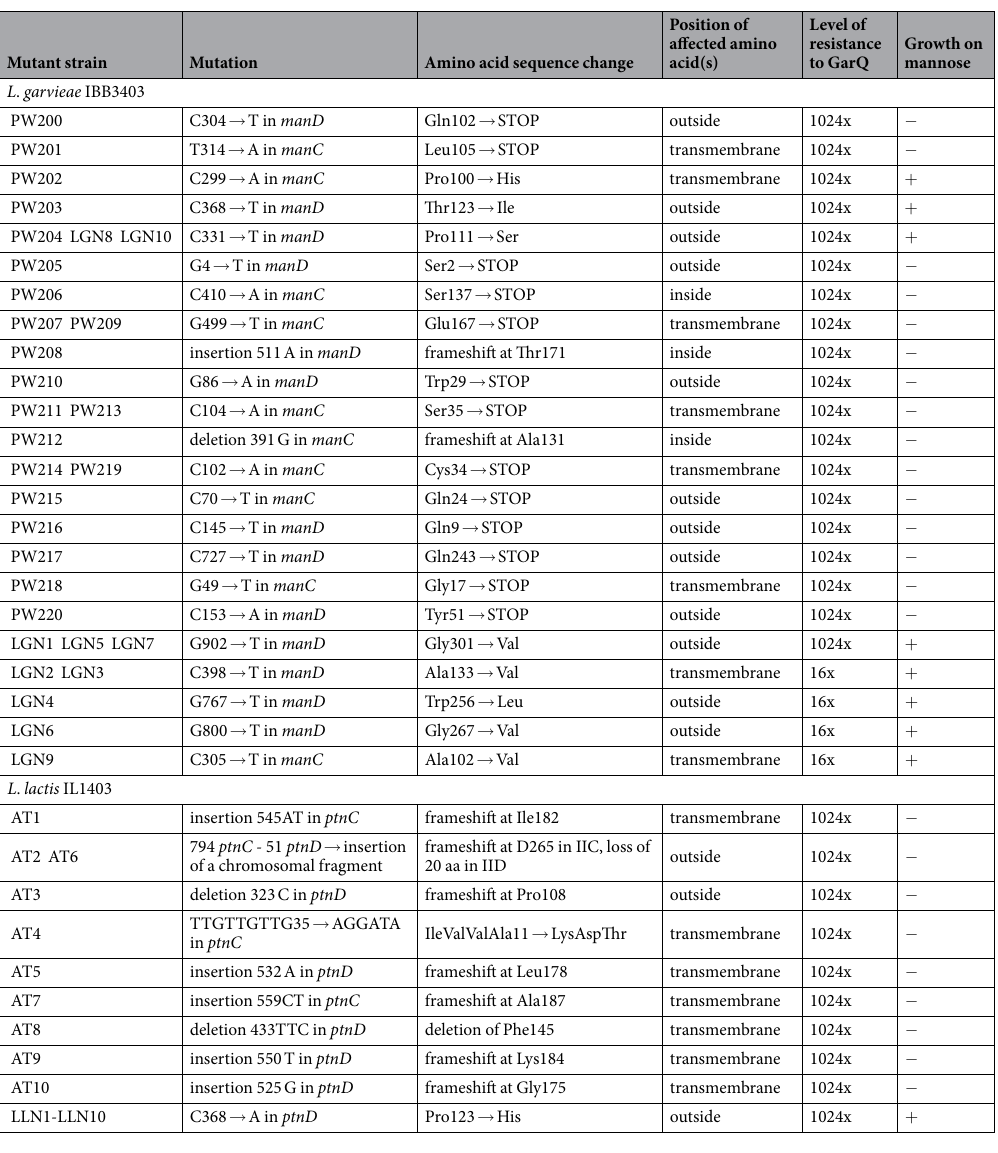
Table 2. Spontaneous L . garvieae IBB3403 and L . lactis IL1403 mutants resistant to